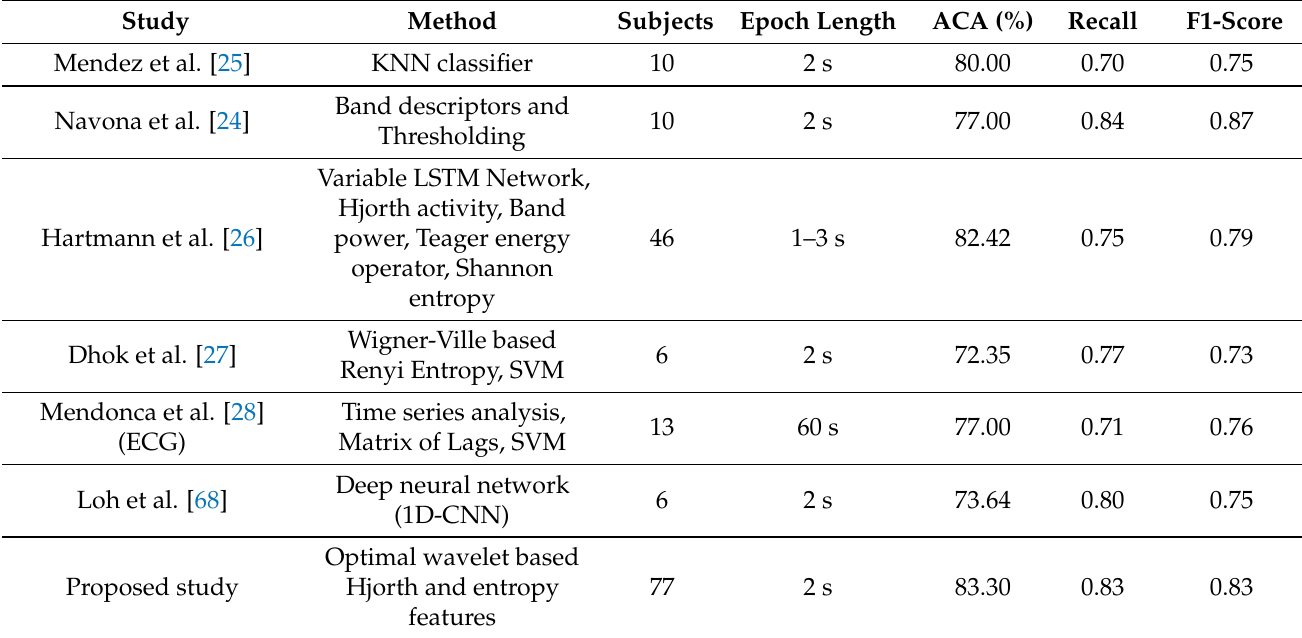
Table 15. Comparison our study with state-of-the-art techniques for CAP phase identification using healthy